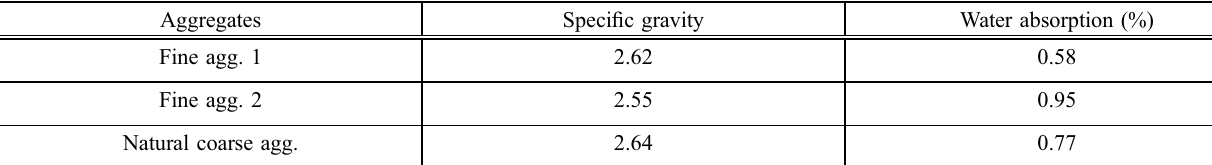
Table 2 Aggregate material properties.